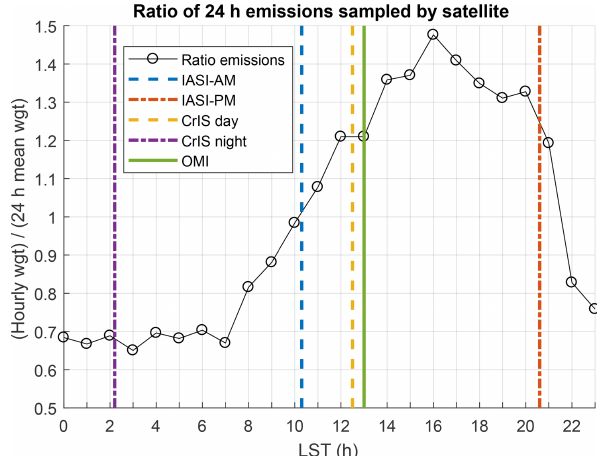
Figure 7. Ratio of 24h emission rates sampled by satellite at various LST. The y axis shows the ratio of the hourly emission weight over the 24h mean emission weight. The typical overpass times for the IASI, CrIS, and OMI satellites over the Horse River fire area are also